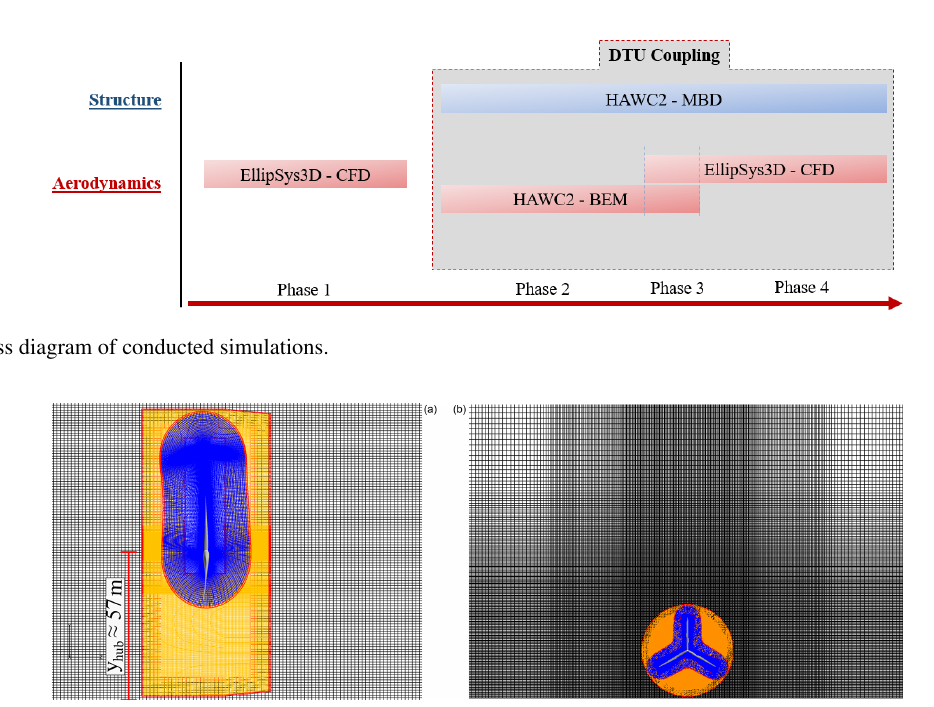
Figure 4. Grids used for simulations. (a) Side view, (b) front view. Red cells show receiver cells of overlapping grids. Blue: rotor grid. Orange: disc grid. Black: background grid. Entire background grid is not